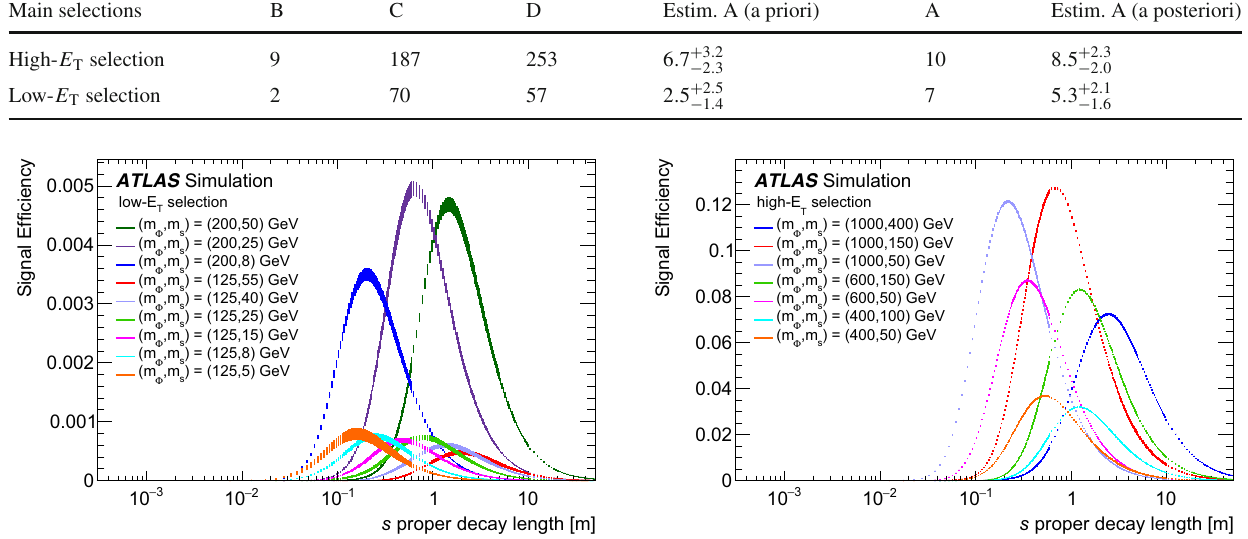
Fig. 7 The extrapolated signal efficiencies as a function of proper decay length of the s for several simulated samples in the low- E T (left) and high- E T (right) selections. The vertical error bars represent the statistical